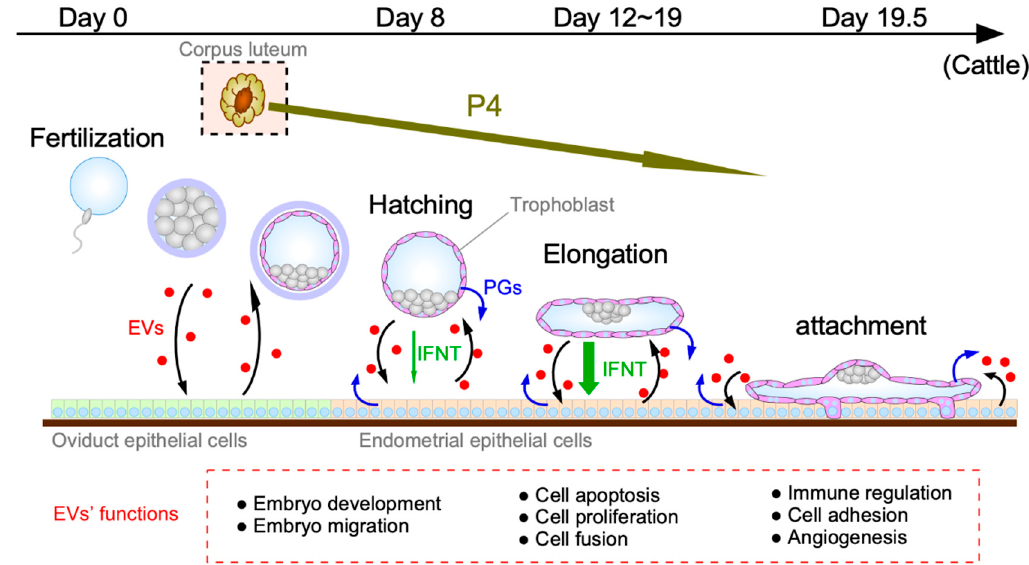
Figure 2. Roles of uterine extracellular vesicles (EVs) during the peri-implantation period. In domestic ruminants, the process of conceptus implantation to the maternal endometrium consists of blastocyst hatching, elongation, migration, apposition/attachment, and subsequent formation of the placenta. During these stages, EVs secreted by the conceptus and/or endometrium into the uterine microenvironment could have autocrine and/or paracrine biological effects on appropriate communication between the conceptus and the uterine endometrium. EVs are also interactive and coordinate with ovarian progesterone (P4), embryo-derived interferon tau (IFNT), and prostaglandins (PGs) for successful conceptus implantation and subsequent pregnancy